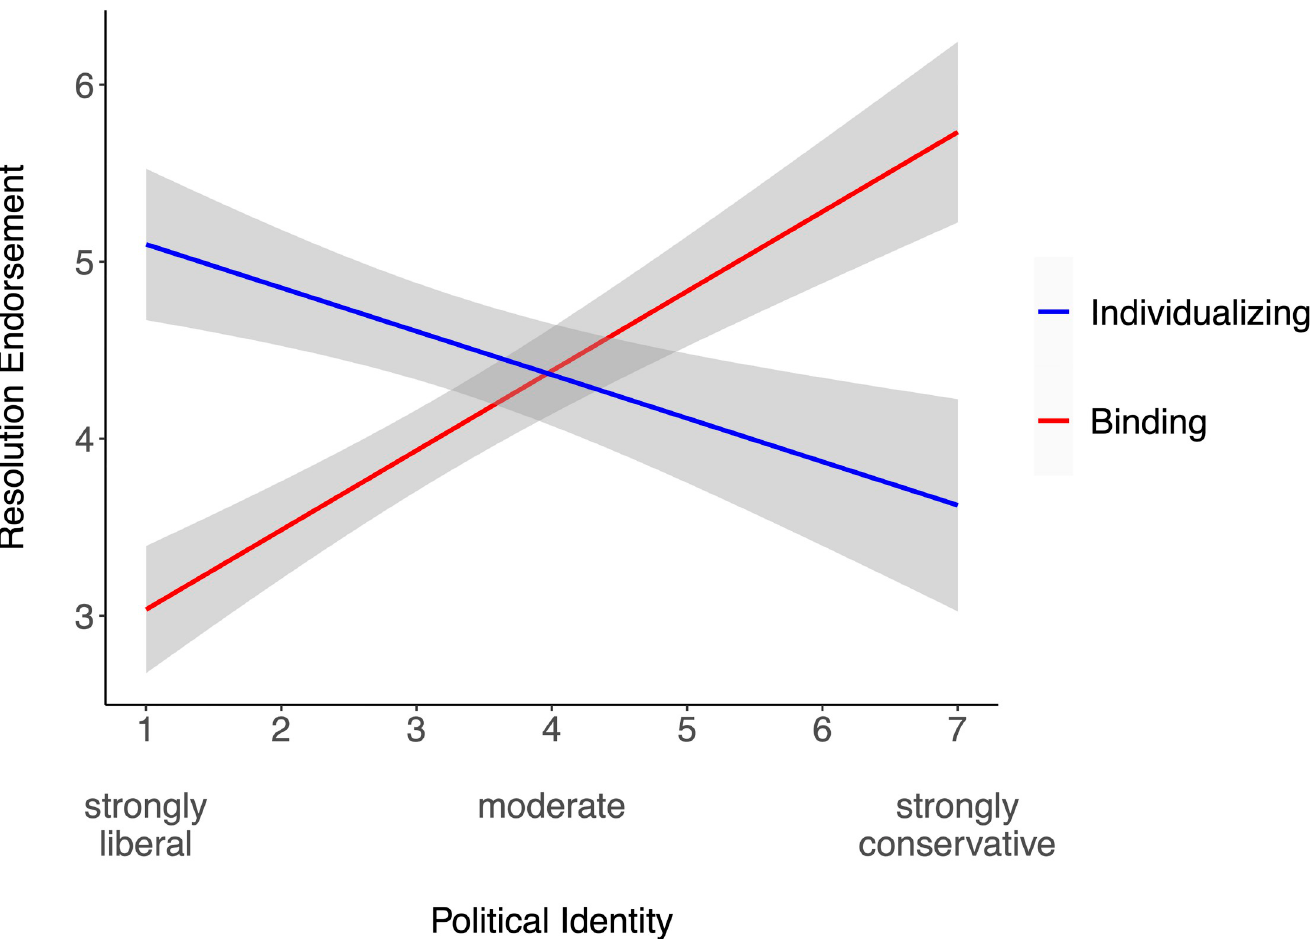
Fig 4. Association between political identity and endorsement of individualizing and binding moral resolutions. The plot depicts the 95% CI around each regression line. Two final regression models predicted resolution endorsement with political identity and both individualizing- and binding-MFQ aggregates as predictors. Stronger conservatism nega- tively predicted endorsement of individualizing resolutions, β = -.23, t (104) = -1.99, p = .048